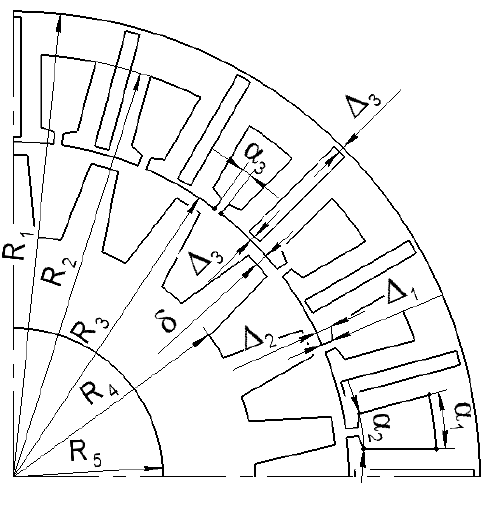
Figure 4. Optimization parameters. Table 5. The fixed FSG parameters during the optimization.